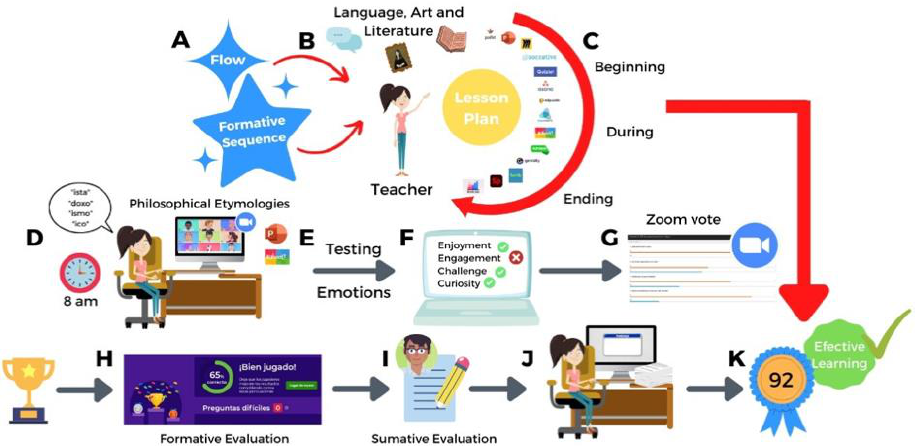
Figure 4. ( A ) The teacher considers the flow and the ( B ) formative sequence’s theoretical and conceptual elements to integrate the instructional design of an online class session within his/her lesson